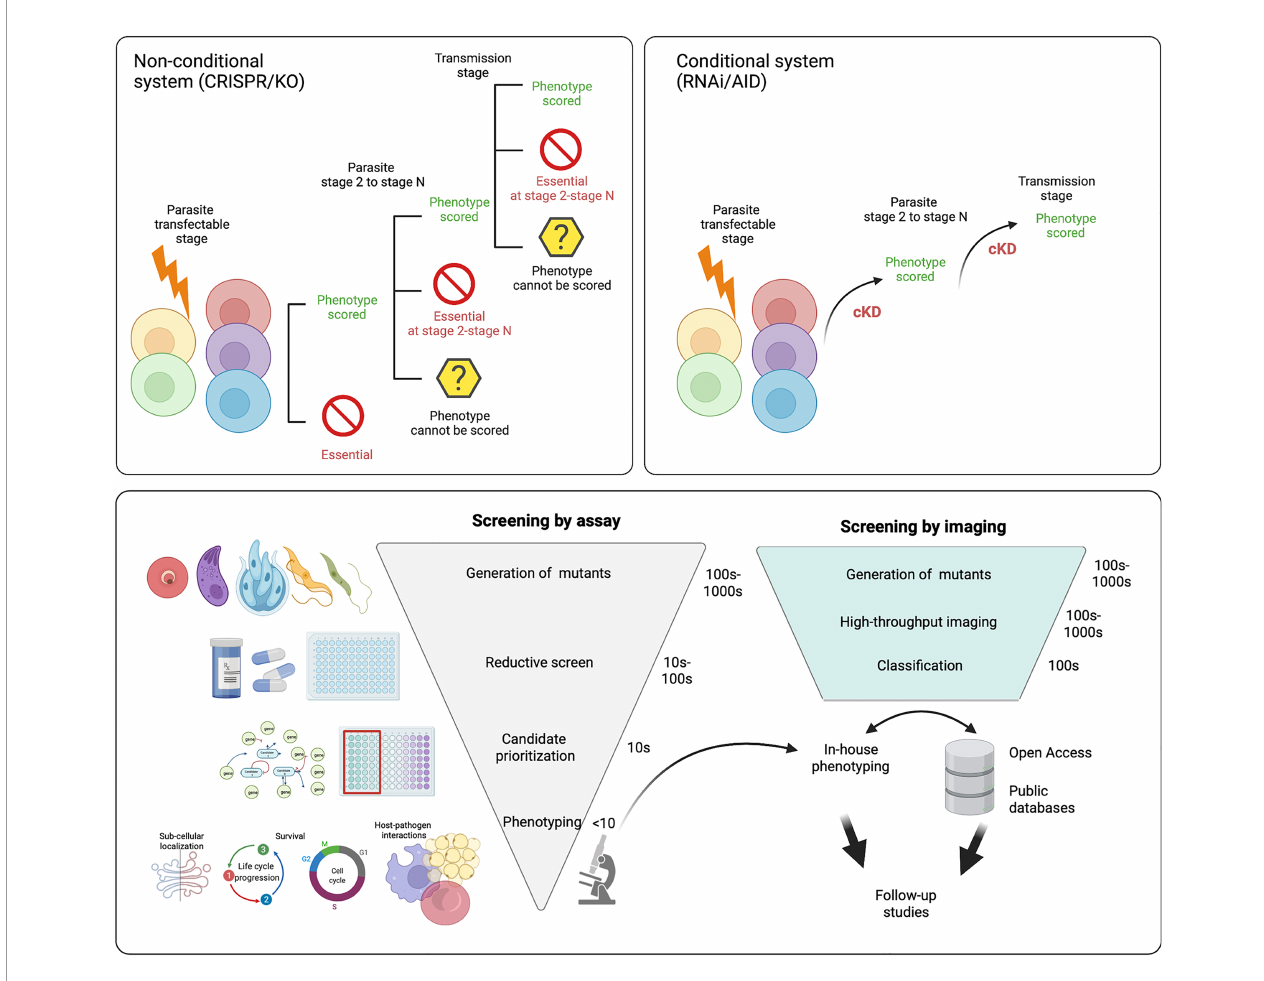
FIGURE 8 | Future directions for functional screens. Most functional screens in Apicomplexa rely on non-conditional gene depletion methods to phenotype mutants. Top left panel After the gene(s) of interest has been disrupted only those that are dispensable for growth during the transfected stage can be phenotyped. With life cycle progression (through stages 2 - N) more mutants within the pool will be lost as they become critical for survival. This means even without reducing the population with selective pressure (eg. drug) the number of mutants within the pool that can be characterised is not complete across the life cycle. Top right panel In conditional regulation systems the means of downregulation are integrated (eg. the auxin tag for the AID system) following transfection. Of note it is likely a few candidates will not tolerate the tag and will be lost from the population. As downregulation can be induced across the life cycle, all mutants within the population can be characterised and none are lost due to prior stage essentiality. Bottom panel After generation of mutants, many functional screens rely on reductive assays to select mutants with a speci fi c phenotype (eg. drug resistance). This is followed by further candidate prioritisation before in-house phenotyping of a small number of mutants, often re-derived as conditionally regulatable knockdowns to allow characterisation throughout the life cycle. If pools of mutants are instead characterised by high-throughput imaging, they can be classi fi ed based on tagged protein localisation or, mutant phenotype. Classi fi cation of mutants allows for in house phenotyping and open access data sharing distributes follow up studies throughout the fi eld and improves equitability. Figure created with